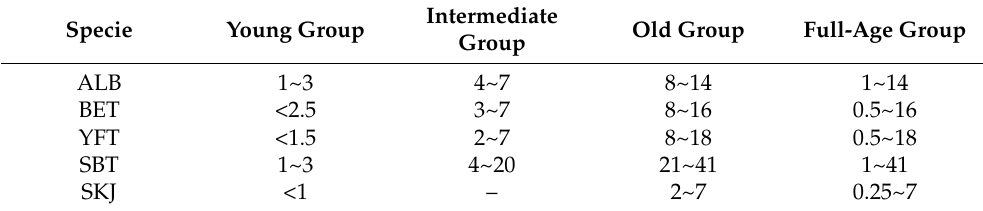
Table 2. Sampled age ranges of five tuna